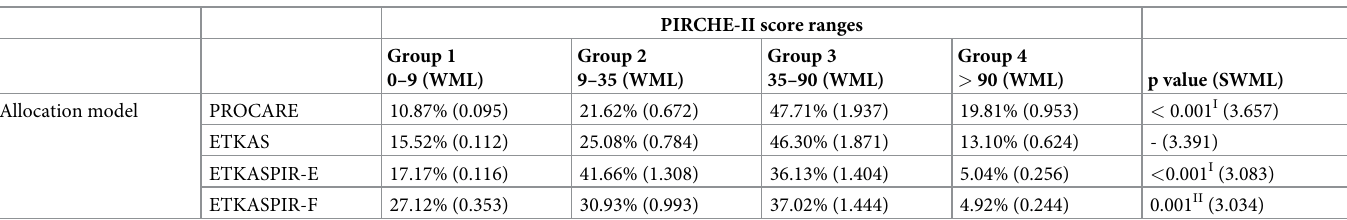
Table 2. PIRCHE-II distribution per risk strata in